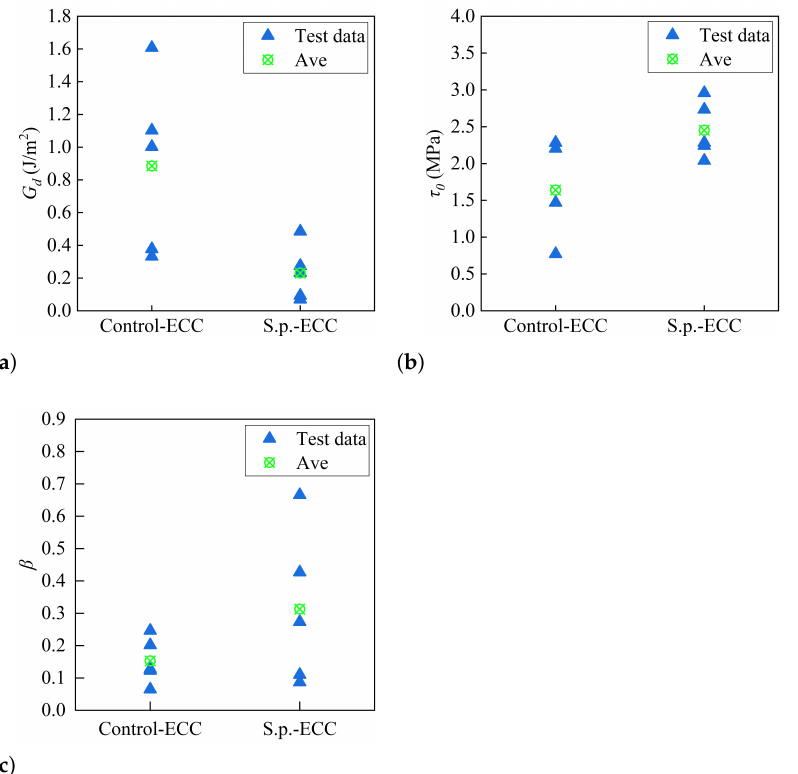
Figure 17. Comparison of interface parameters for single fiber pullout tests. ( a ) Chemical bond. ( b ) Frictional bond strength. ( c ) Slip-hardening coefficient.